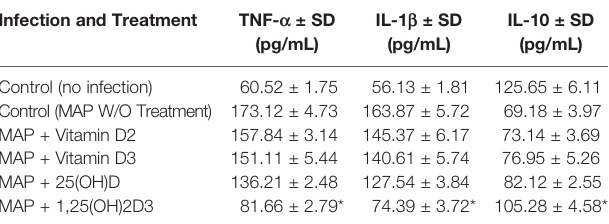
TABLE 1 | Effect of Vitamin D treatment on cytokine production in MAP-infected macrophages. Infection and